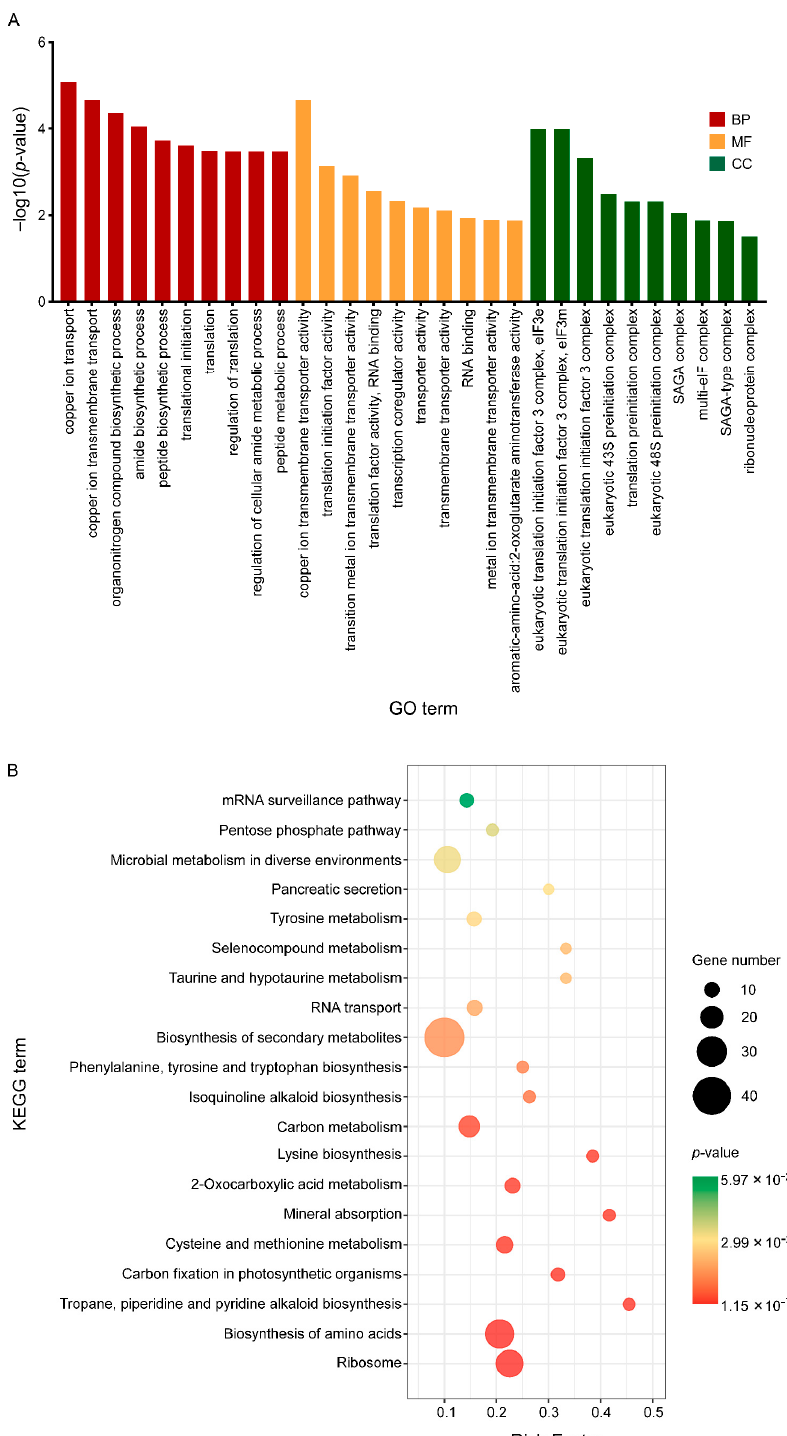
axis indicates different GO terms, and the y-axis indicates − log10 (corrected p -value) in each cate- gory. The top 10 enriched pathways of each category are shown in the figure. B. Scatter plot of en- riched KEGG pathways. The rich factor is the ratio of the number of genes that were differentially expressed to the total number of genes in a certain pathway. The top 20 enriched pathways are shown in the figure.